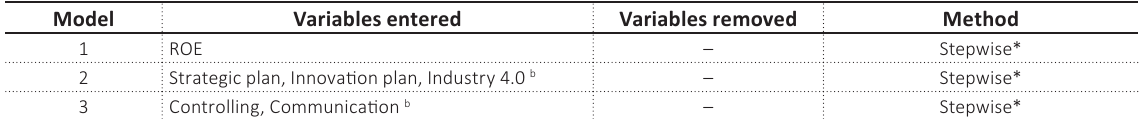
Source: Authors’ data, own processing.